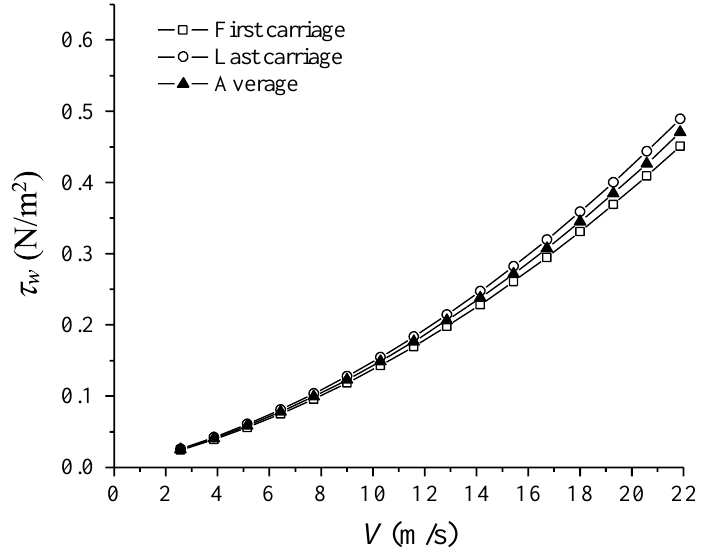
Figure 8. Dependence on the train speed V of the wall shear stresses τ wf measured on the first carriage, τ wl on the last carriage and their average τ wa in the free-cooling mode.